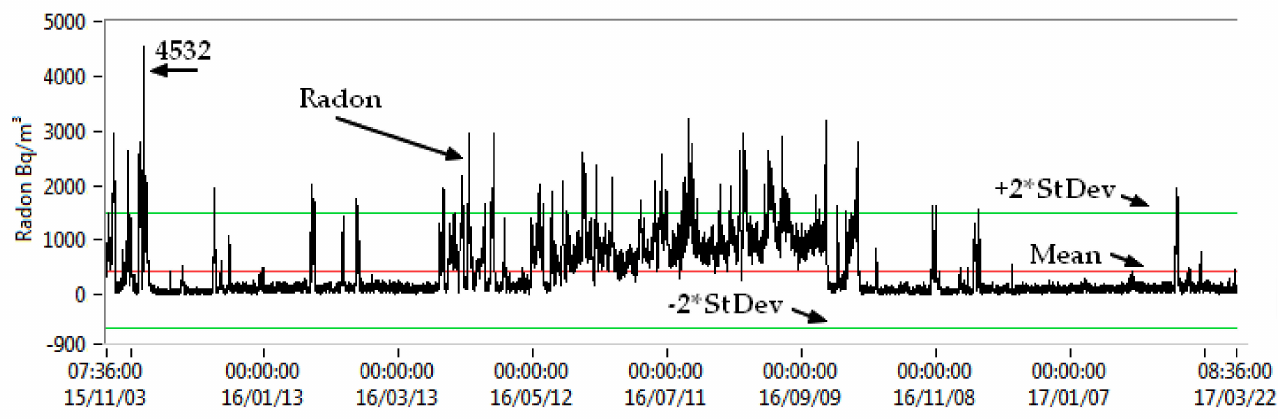
Figure 4. Radon in the tunnel of the Muntele Rosu station (MLRd, StDev is Standard Deviation, format of 15/11/03 is yy/mm/dd).